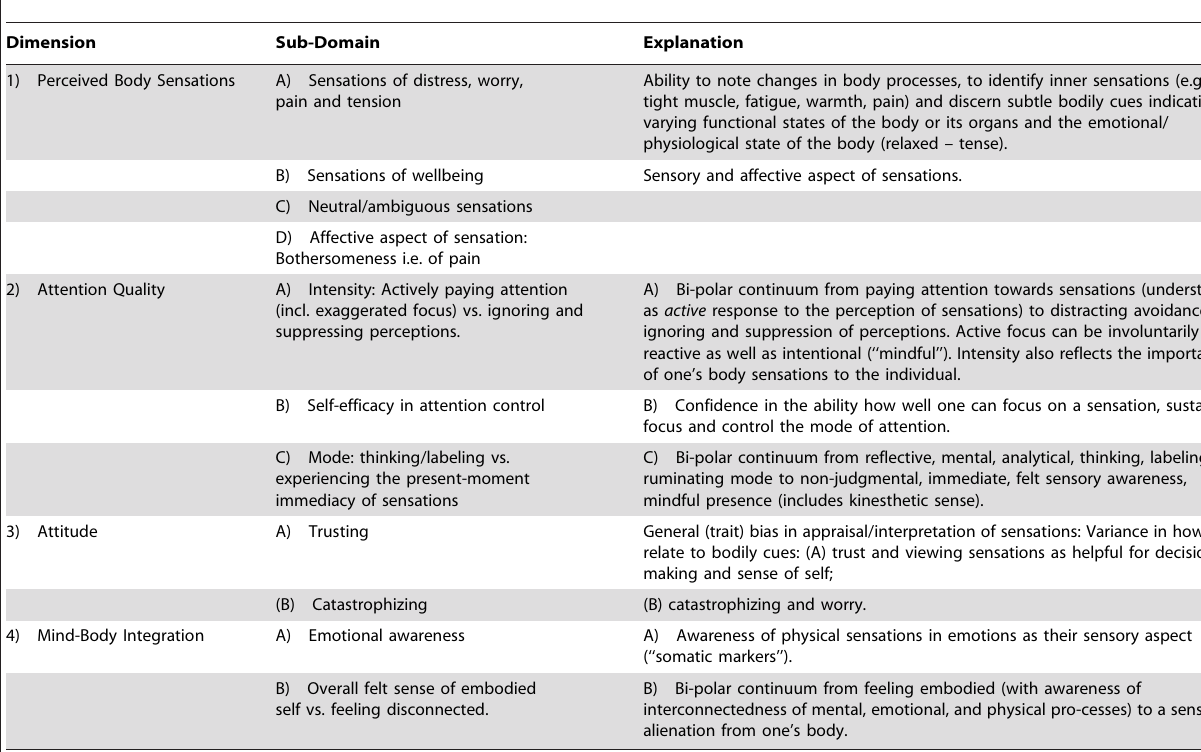
Table 5. Dimensions of Body Awareness (further details: see in ‘Results’).